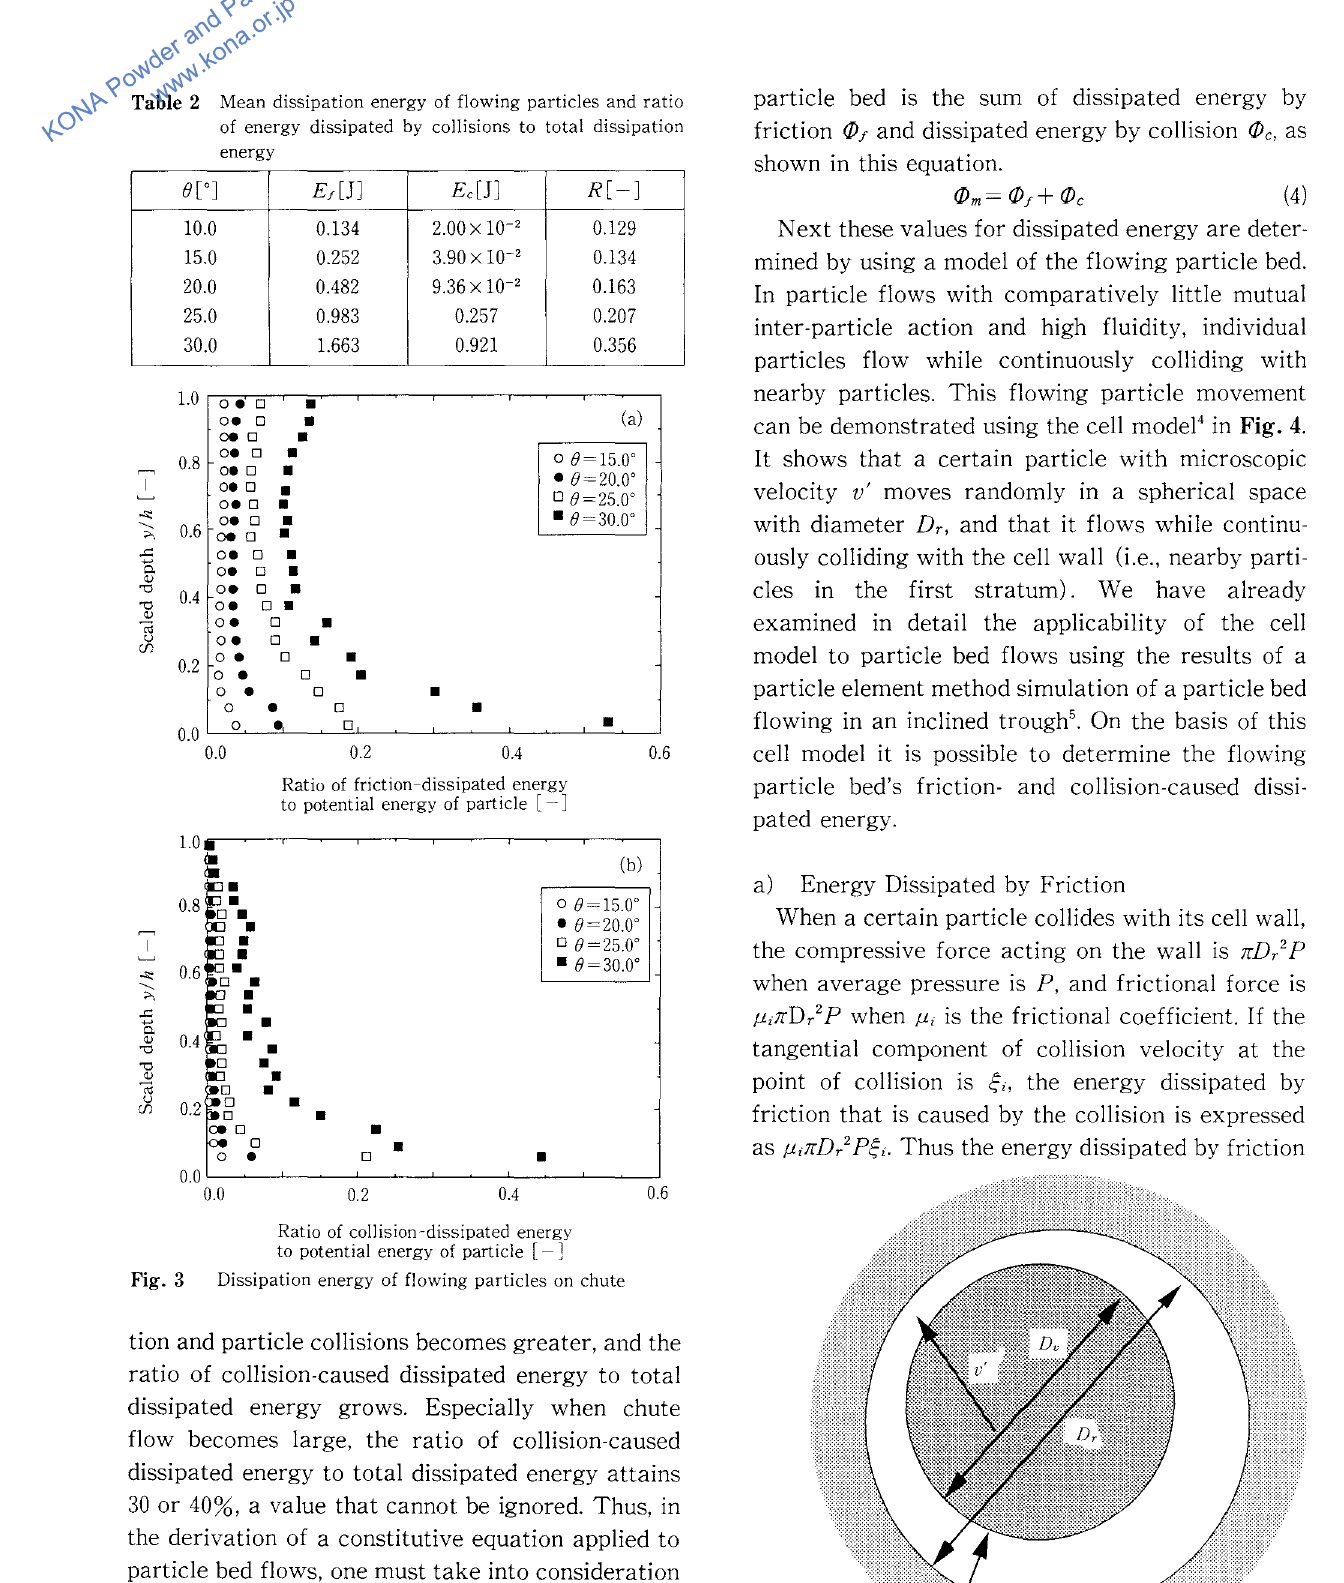
Table 2 Mean dissipation energy of flowing particles and ratio of energy dissipated by collisions to total dissipation energy